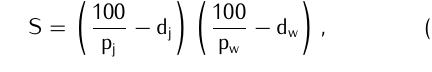
Figure 3. Digital images of Sample 2 (a) and Sample 14 (b), taken under 4x